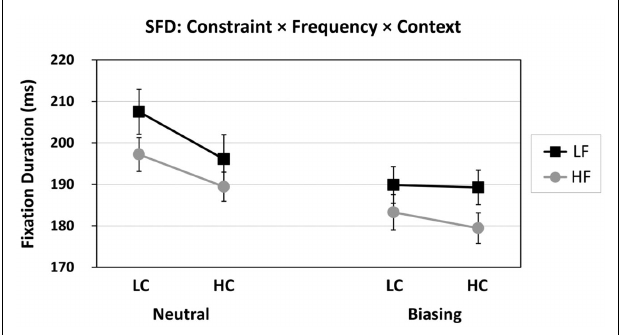
FIGURE 1 |Average single fixation duration (ms), with SE bars, on target words as a function of Constraint (LC, HC), Frequency (LF, HF), and Context (Neutral, Biasing). SFD, single fixation duration; LC, low constraint; HC, high constraint; LF, low frequency; HF, high frequency.